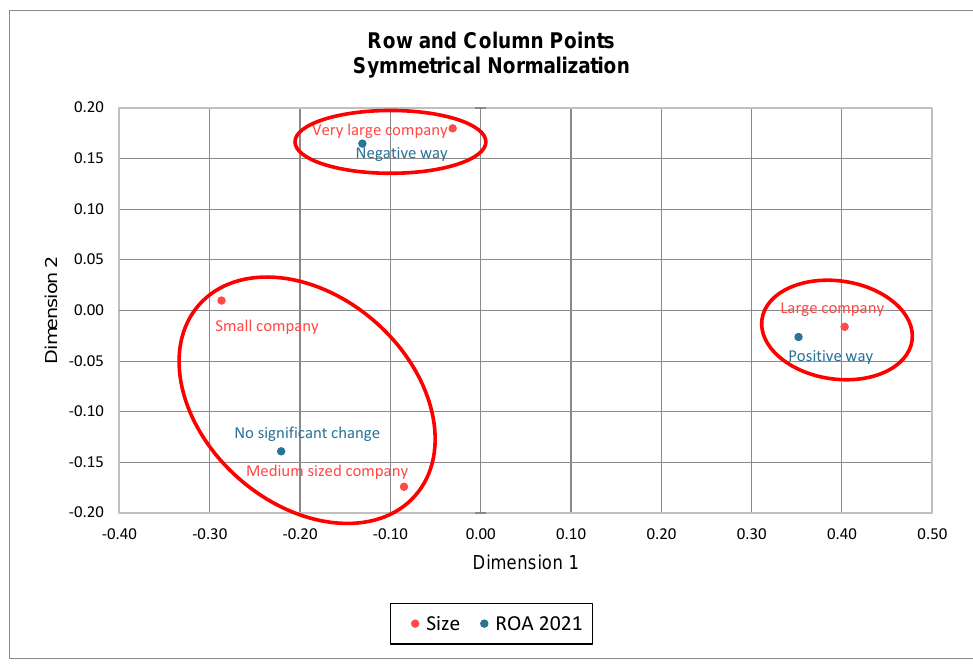
Figure 8. Correspondence map for ROA indicators in 2021 and enterprise size categories. Source: own research .